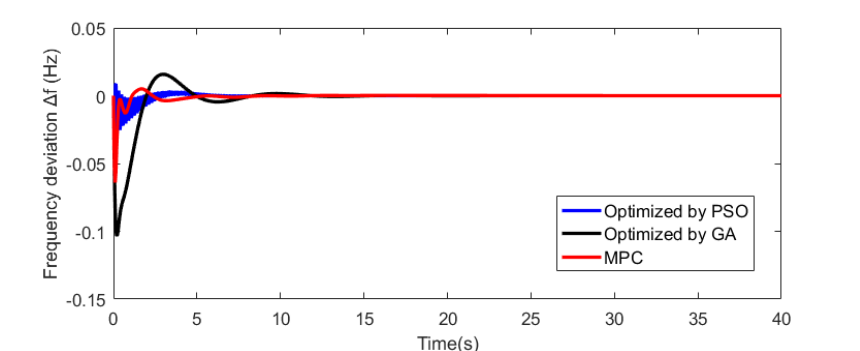
Figure 7. Frequency deviation in Area 1 for the first case.